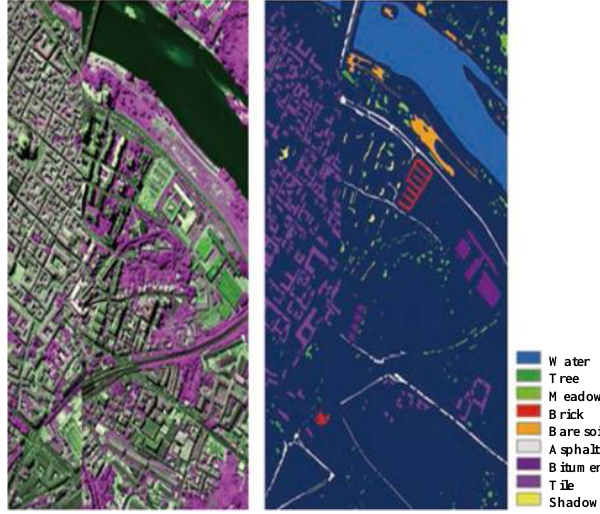
Figure 3. Represents the Pavia Center dataset, Italy, including the RGB map and 9 classes land cover.